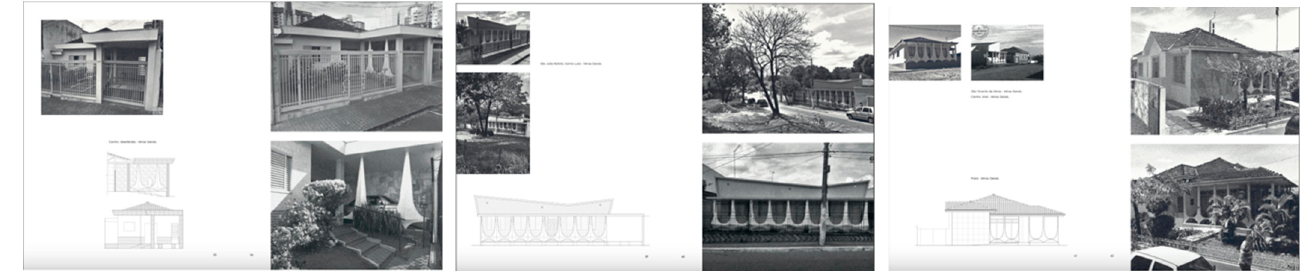
Figure 6. Talles Lopes, Brazilian Construction: Architecture Modern and Old, 1958- , 2018, photobook, courtesy of the artist.